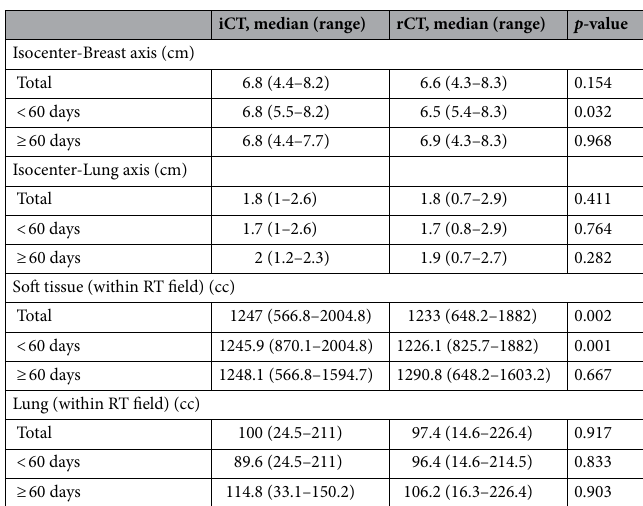
Table 3. Comparative results of measured clinical parameters in iCT and rCT (categorization according to the surgery–simulation interval) ( p -value: Paired t -test).